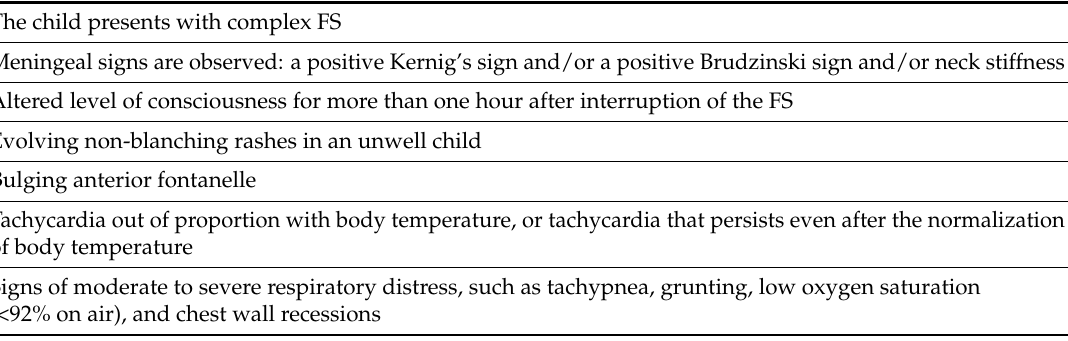
Table 3. Red flag signs and symptoms in a child presenting with febrile seizures